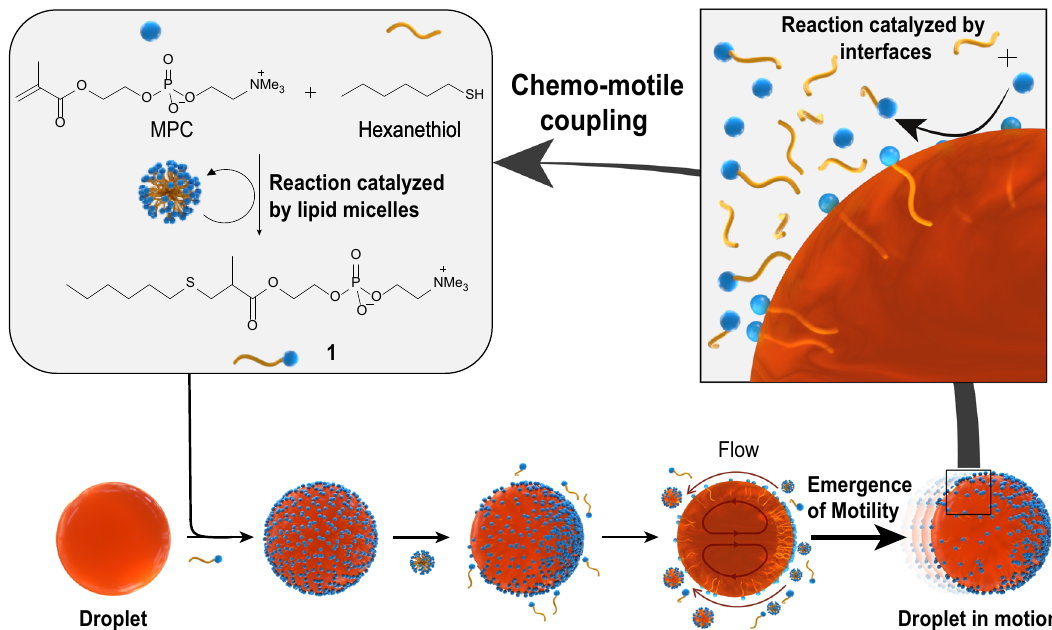
Fig. 1 Mechanisms supporting the motion of microscopic droplets in a lipid system. The Michael reaction between an emulsion of 1-hexanethiol and water-soluble 2-methacryloyloxyethyl phosphorylcholine (MPC) forms lipid 1 , which self-assembles to form micelles in water. Once the concentration of 1 reaches the critical propulsion concentration (CPC), micelles fi lled with oil start forming in the vicinity of the lipid-covered oil droplet, symmetry is broken, and at this point the droplet starts moving towards micelle-rich areas. In return, the rate of lipid self-reproduction is